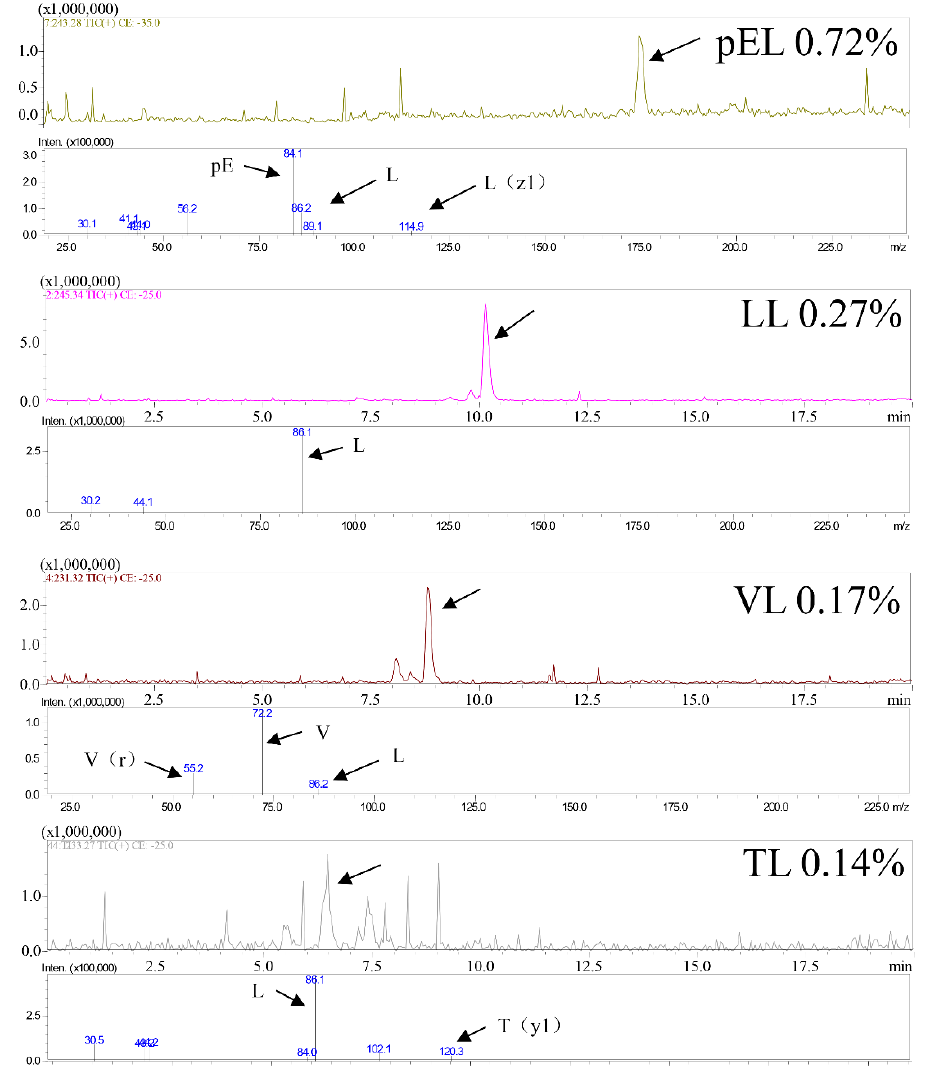
Figure 2. CPs main peptides sequences.